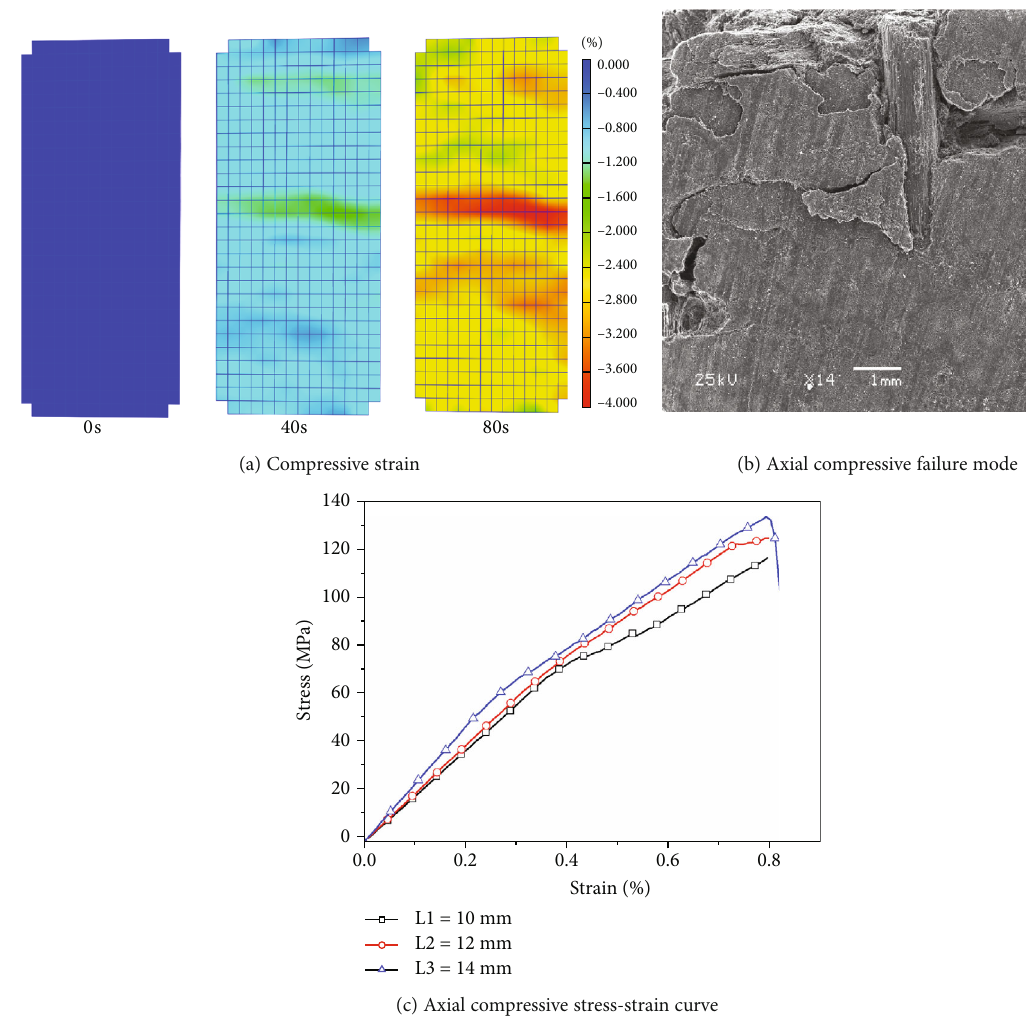
(c) Axial compressive stress-strain curve Figure 10: Axial compression test results.